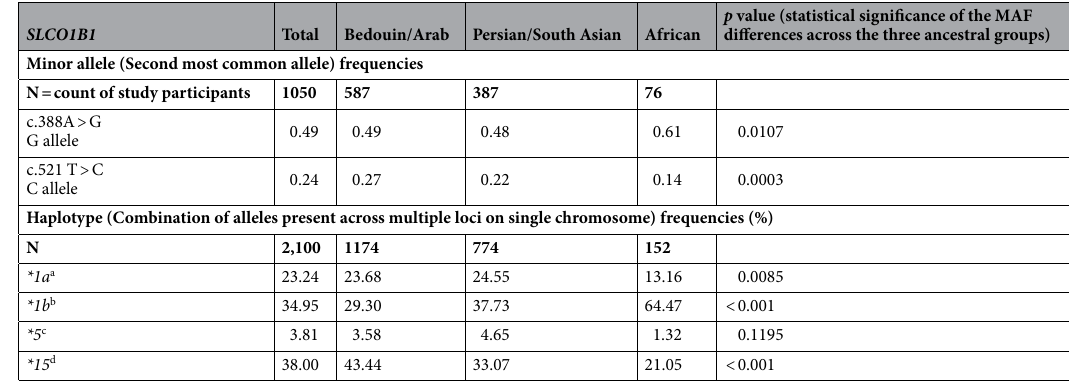
Table 1. Minor allele and haplotype frequencies of SLCO1B1 functional SNPs in Qatar across the three different ancestry groups. Significant value are in [bold]. a = wild type at all loci; b = rs2306283 G allele